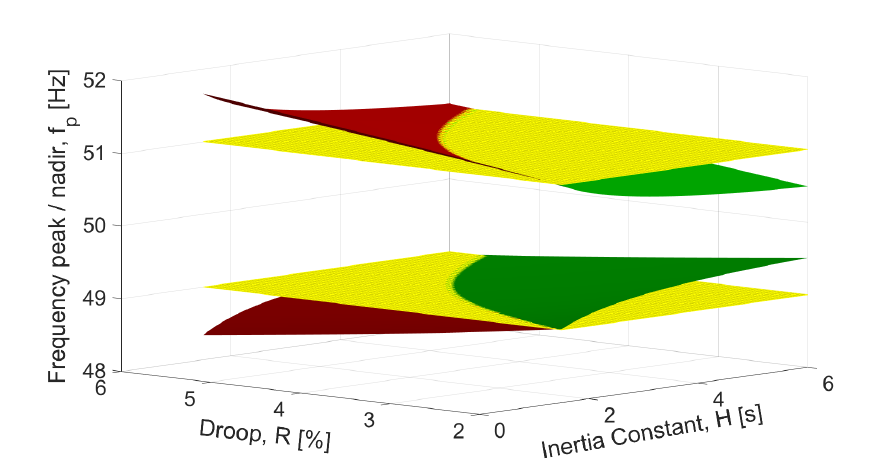
Figure 7. Impacts of R and H on f p for fossil steam